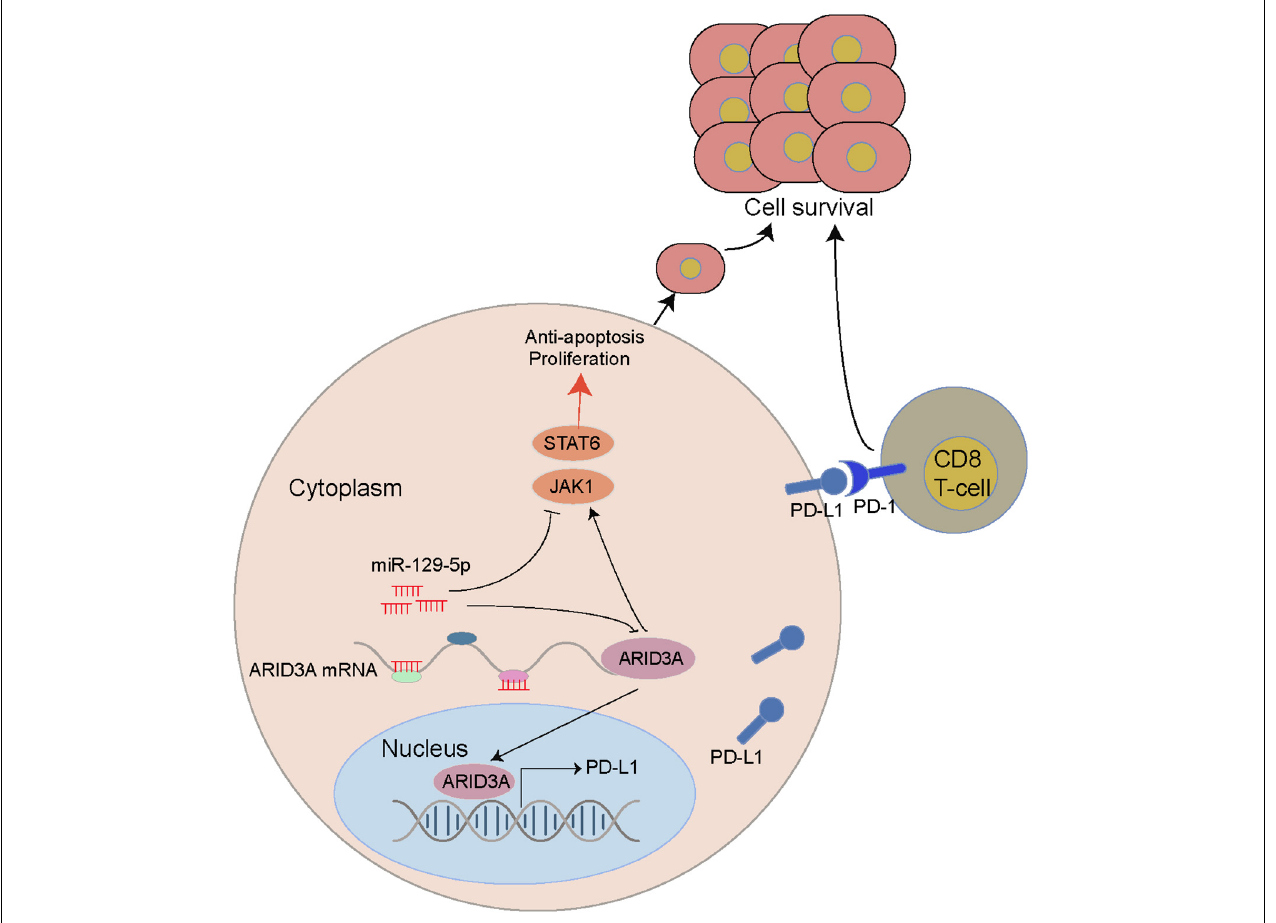
FIGURE 8 | A miR-129-5P/ARID3A negative feedback loop modulates diffuse large B cell lymphoma progression and immune evasion through regulating the PD-1/PD-L1